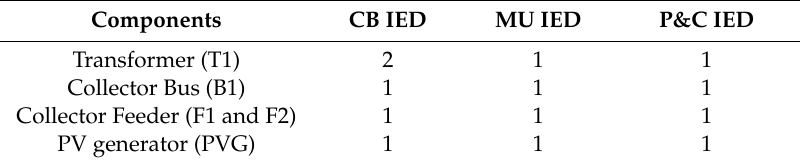
Table 6. Intelligent electric device (IED) configurations for the developed model of the PV power plant.